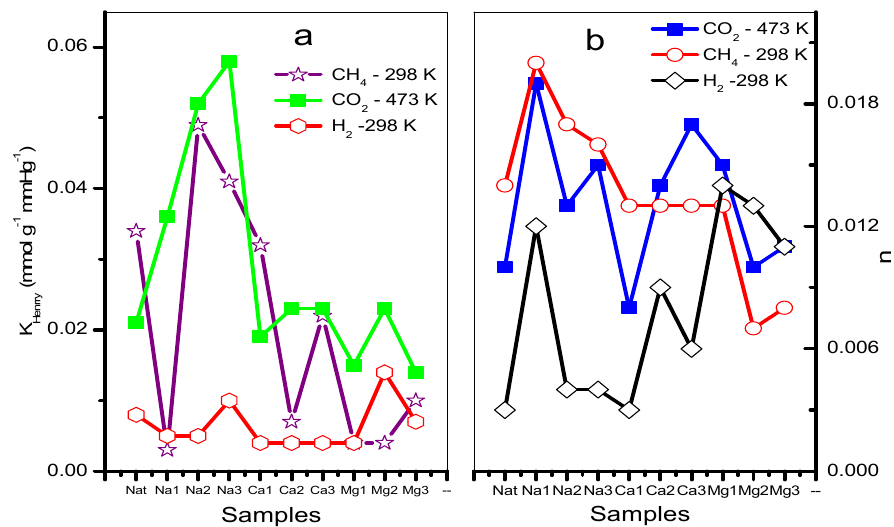
Figure 8. ( a ) Henry ( K H ) and ( b ) Freundlich ( n ) parameters of CO 2 , CH 4 , and H 2 of natural and exchanged chabazite.